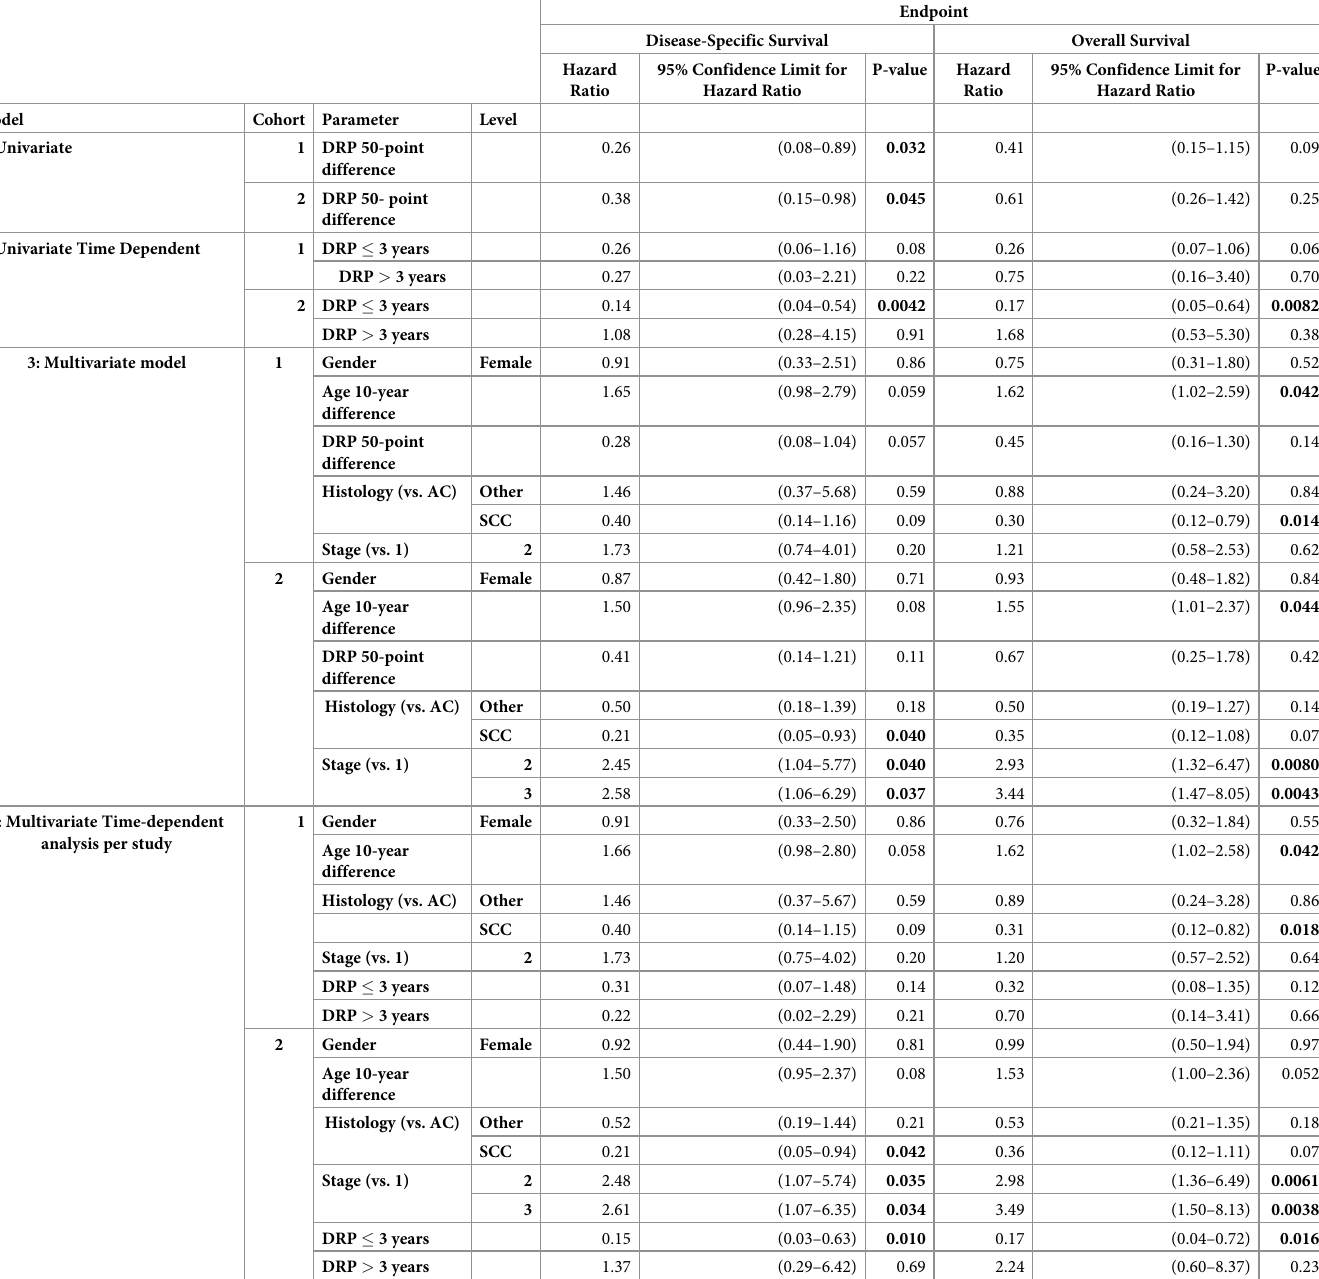
Table 2. Uni- and multivariate model per study, endpoint disease-specific survival and overall